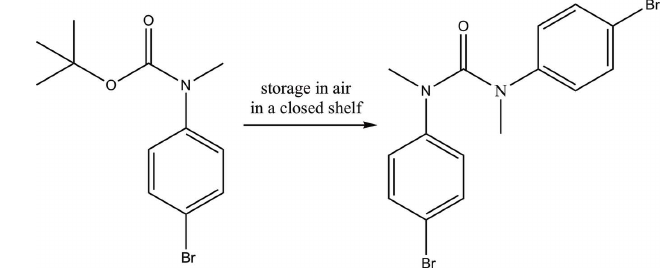
Figure 2 A view of the extended structure of the title compound with hydrogen bonds drawn as dashed lines. Hydrogen atoms not involved in hydrogen bonding have been omitted.